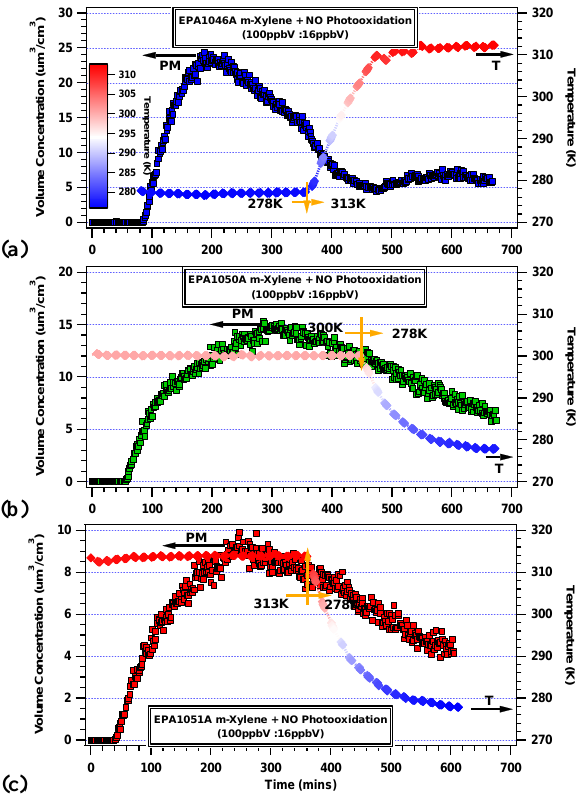
Fig.1 Aerosol formation results for three selected temperature experiments; all three dry non-seeded photooxidation with initial target concentration ( m -xylene ≈ 100 ppb, NO 2 ≈ 16 ppb). Blue squares represent the experiment starting at 278K for 6h irradiation and then heated to 313K; green squares represent the experiment starting at 300K for 7.5h irradiation and then cooled to 278K; red squares represent the experiment starting at 313K for 6h irradiation and then cooled to 278K.